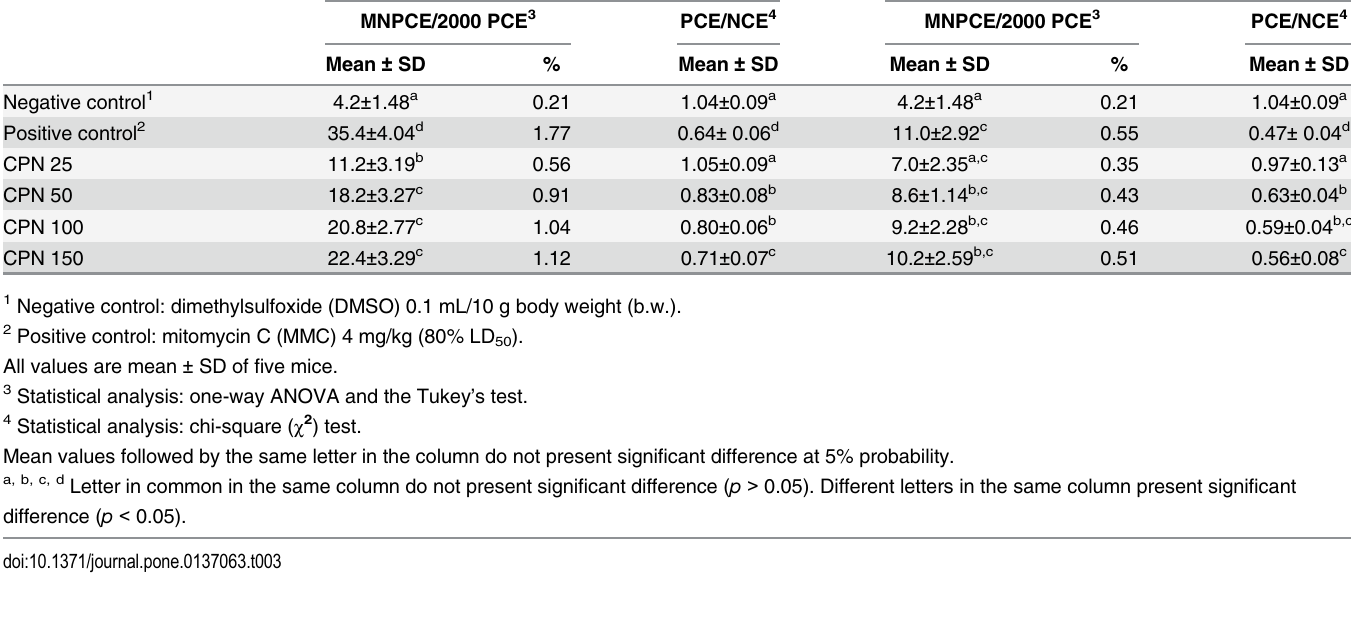
Table 3. Evaluation of cytotoxic and genotoxic activities in the bone marrow of mice treated with sulfonamide chalcone N-{4-[3-(4-nitrophenyl) prop-2-enoyl]phenyl}-benzenesulfonamide (CPN) based on MNPCE and PCE/NCE frequency. Treatment (mg/kg